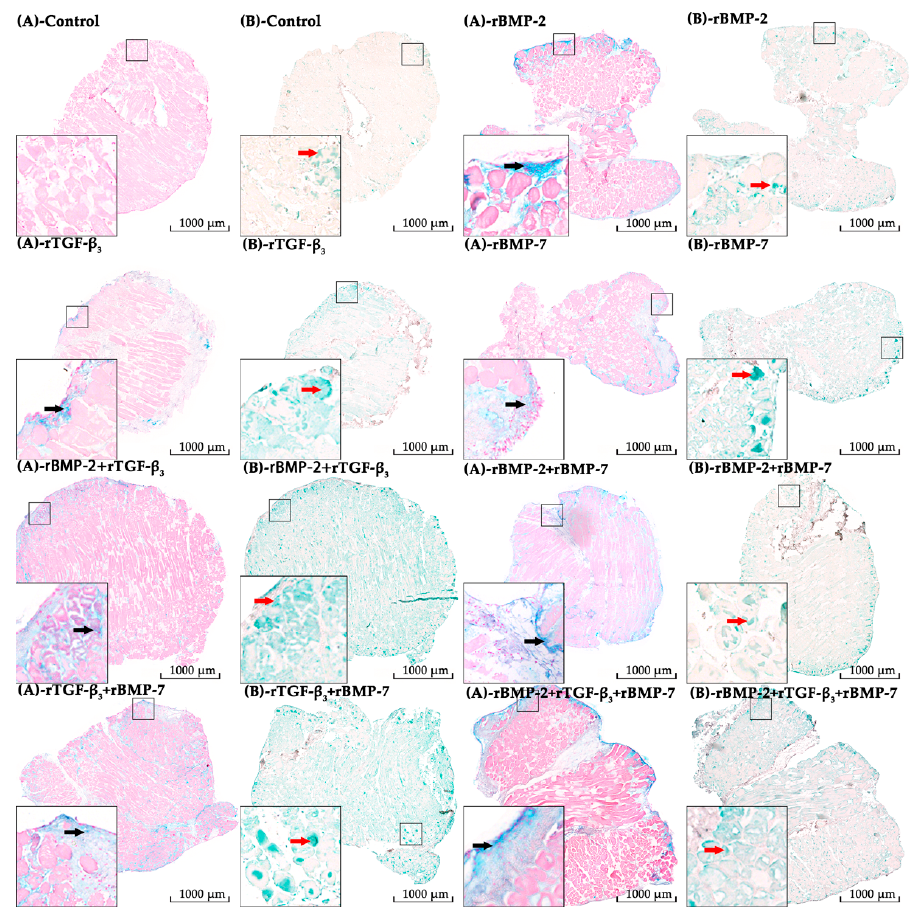
Figure 7. The staining results of the control group and the experimental groups stimulated continuously harvested at culture day 30, including alcian blue staining and immunohistochemistry. ( As ) Alcian blue staining and ( Bs ) immunohistochemistry aggrecan results of the control group and the experimental groups in which morphogens were applied continuously. Positive alcian blue indicated the deposition of low acidic/carboxylated polysaccharides ( black arrows ) with positive antigen-antibody interactions in immunohistochemistry being green ( red arrow ). The magnification was set at 40× . Histomorphometrical analysis of alcian blue staining showed that the positive area ratios were lower than 5% at three culturing time points in the control group, although it presented an increasing